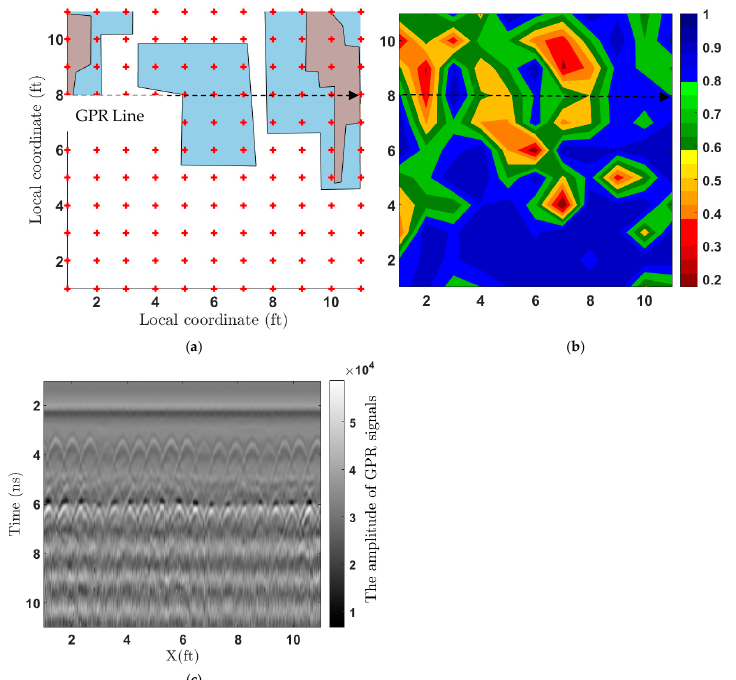
Figure 15. FR SB origin C ( a ) ground truth, ( b ) frequency approach, and ( c ) B scan of the GPR profile (local coordinate Y = 8).